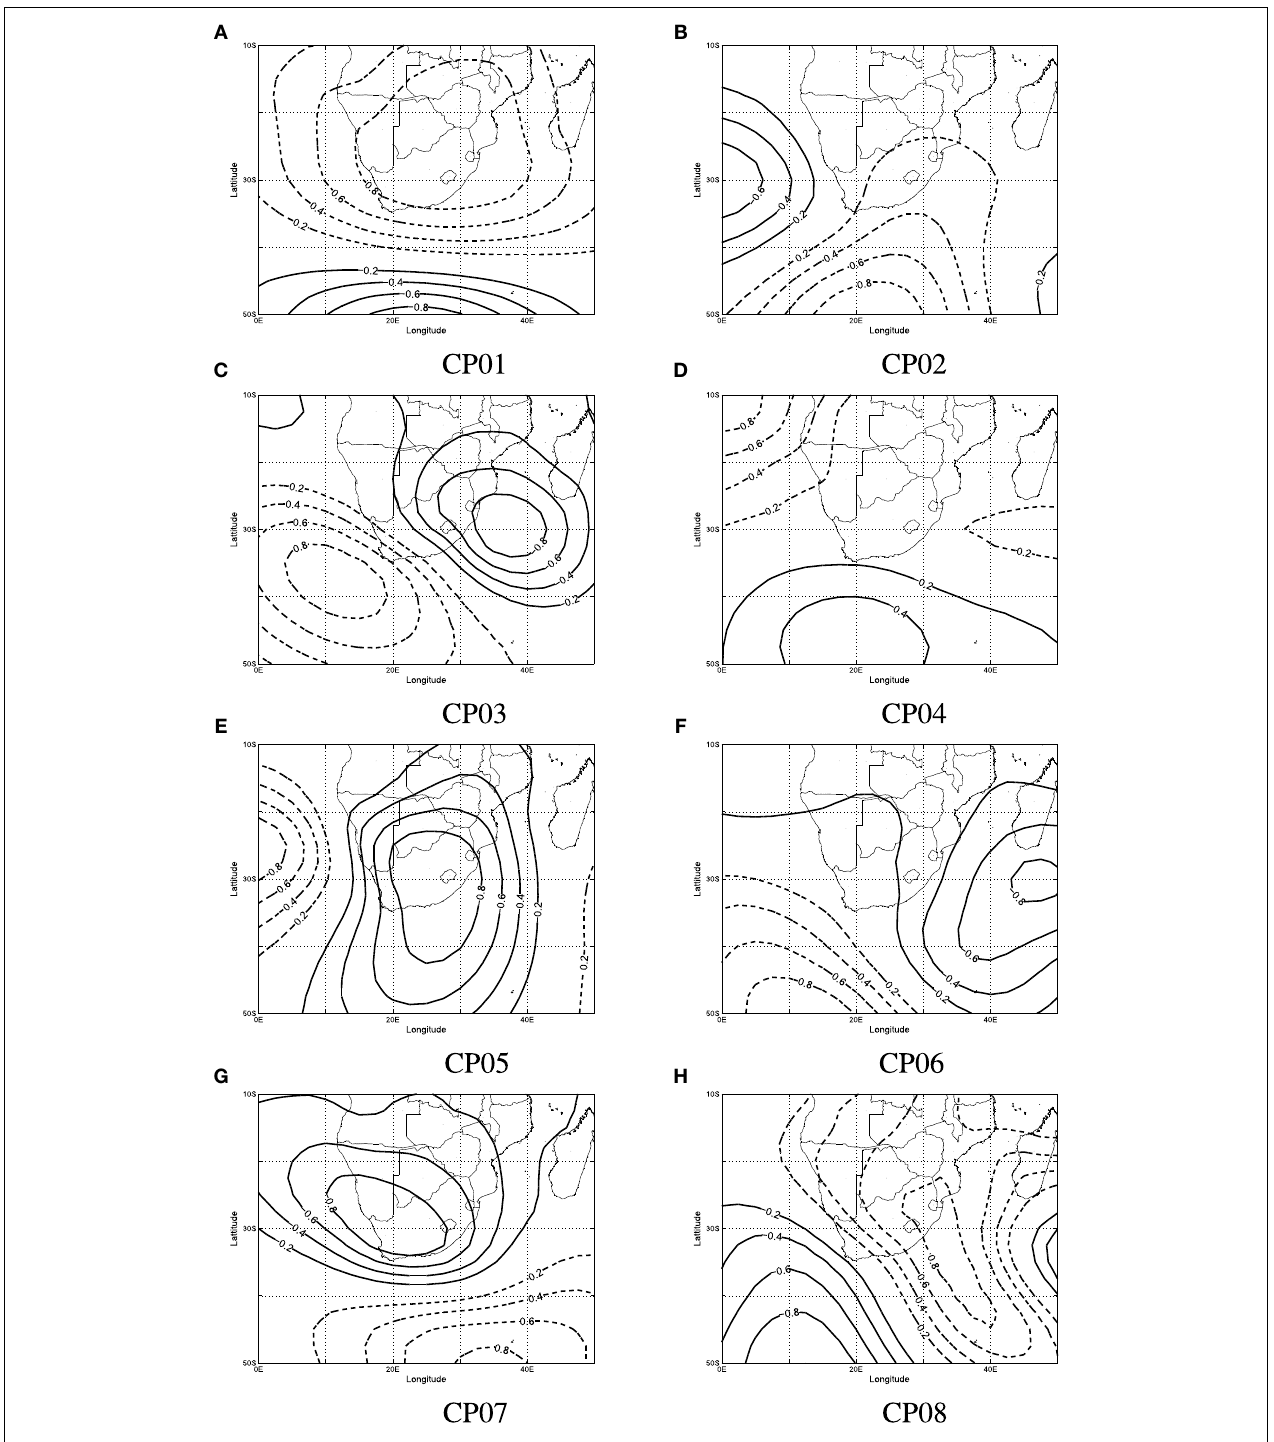
FIGURE 5 | Average anomaly patterns for 8 CP classes derived from the regional wave climate data. Negative (low) pressure anomaly contours are shown as solid lines while positive pressure contours are dashed.